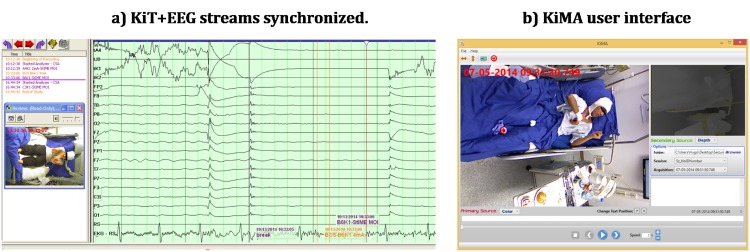
KiT+EEG and KiMA representations.Synchronized multiple EEG channels with the KiT software (Fig A). Optimized field-of-view of the Kinect installed in the epilepsy room, showed in KiMA’s user interface (Fig B). The typical distances range between the sensor and the bed center ranges from 1.9–2.1 meters.